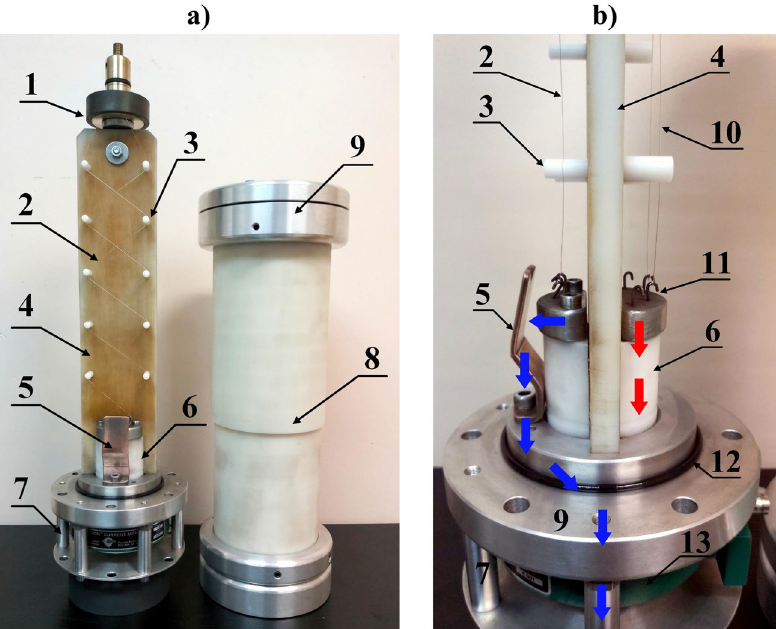
Figure 11. Photographs of the TSFF laboratory model: view from the side of the forming stage and commutation spark gap ( a ) and a profile with a close-up view of the commutation spark gap structure ( b ): 1— quick mounting system for fusible elements, 2—forming stage fusible elements, 3—insulating supports, 4—fuse compartment insulating partition, 5—CSG adjustable electrode, 6—bushing insulator and support for lower internal fitting of fusible elements, 7—external fuse cage with an integrated current measuring transducer for measuring fuse current components, 8—insulating tube of the fuse compartment, 9—external fuse fitting, 10— preparatory stage fusible elements, 11—lower internal fittings with hooks, 12—gas seal of the fuse compartment, 13—broadband pulse current measuring transducer. The approximate current flow path of the preparatory stage is marked with red arrows, while the blue arrows indicate the forming stage current flow